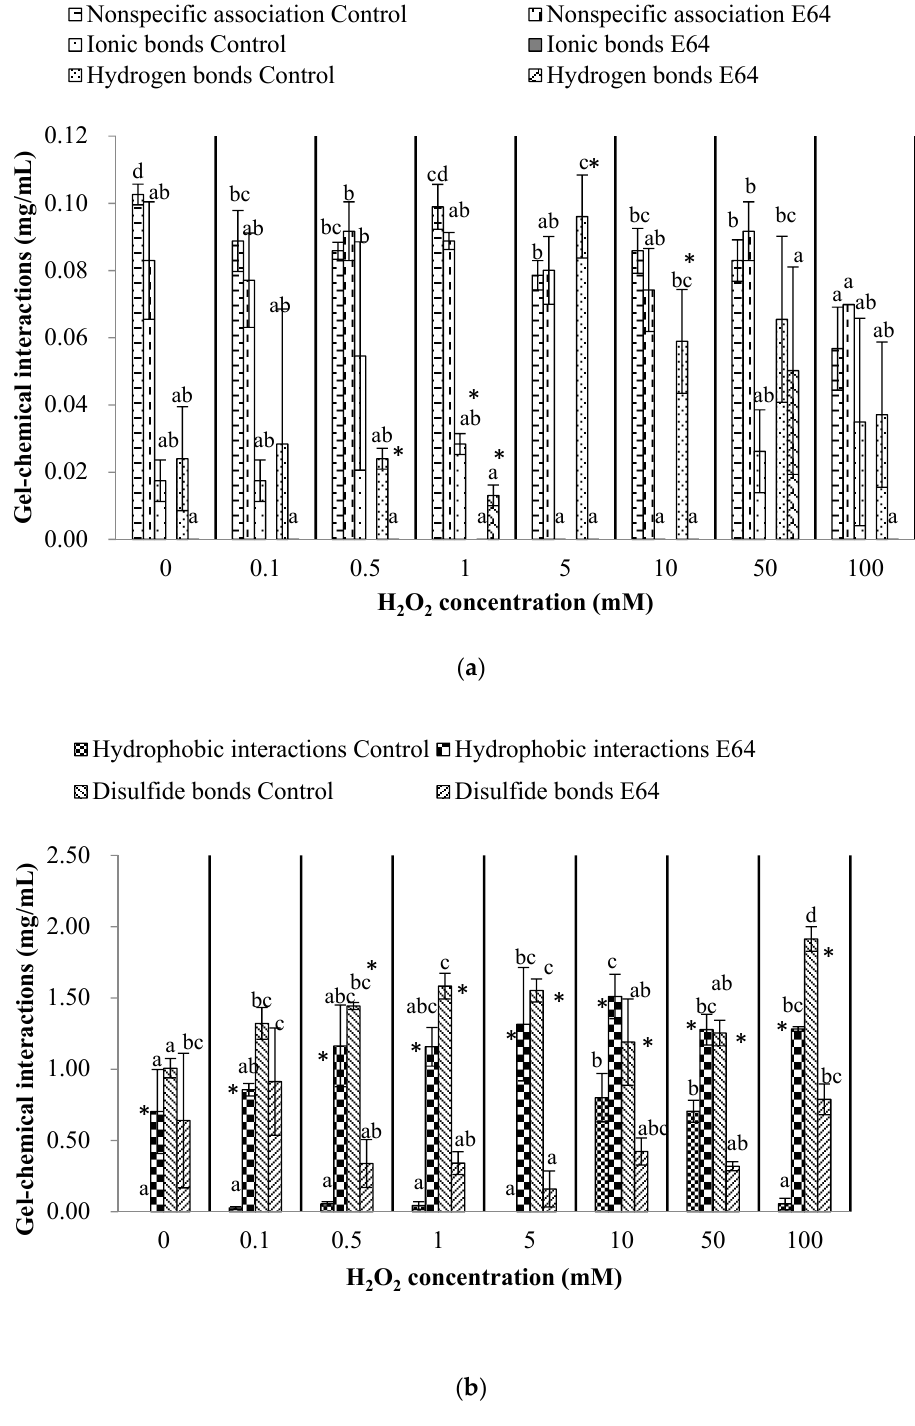
Figure 5. Nonspecific association, ionic bonds, and hydrogen bonds ( a ); hydrophobic interaction and disulfide bonds ( b ) of gels from bighead carps under different H 2 O 2 concentrations. The same lowercase letter indicates no significant differences between samples of control/E64 group under different H 2 O 2 concentrations (the ionic bonds of E64 were 0 mg/mL so the data and lowercase letter were not shown in ( a ). The asterisk indicates significant difference between samples at control and E64 groups under the same H 2 O 2 concentration ( p < 0.05).